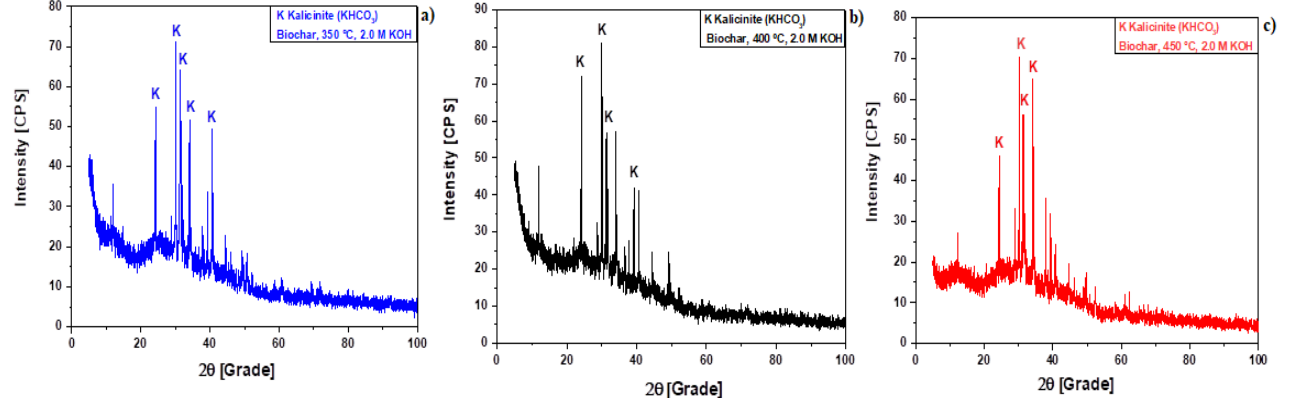
Figure 2. XRD of biochar produced by pyrolysis of Açaí seeds at 350, 400, and 450 °C, 1.0 atm, acti- vated with 2.0 M KOH, in laboratory scale. ( a ) 350 °C; ( b ) 400 °C; ( c ) 450 °C. activated with 2.0 M KOH, in laboratory scale. ( a ) 350 ◦ C; ( b ) 400 ◦ C; ( c ) 450 ◦ C. Table 1. Analysis of peaks characteristics (Intensity, Position: 2 θ , Percentage: %) of crystalline phases identified by XRD in